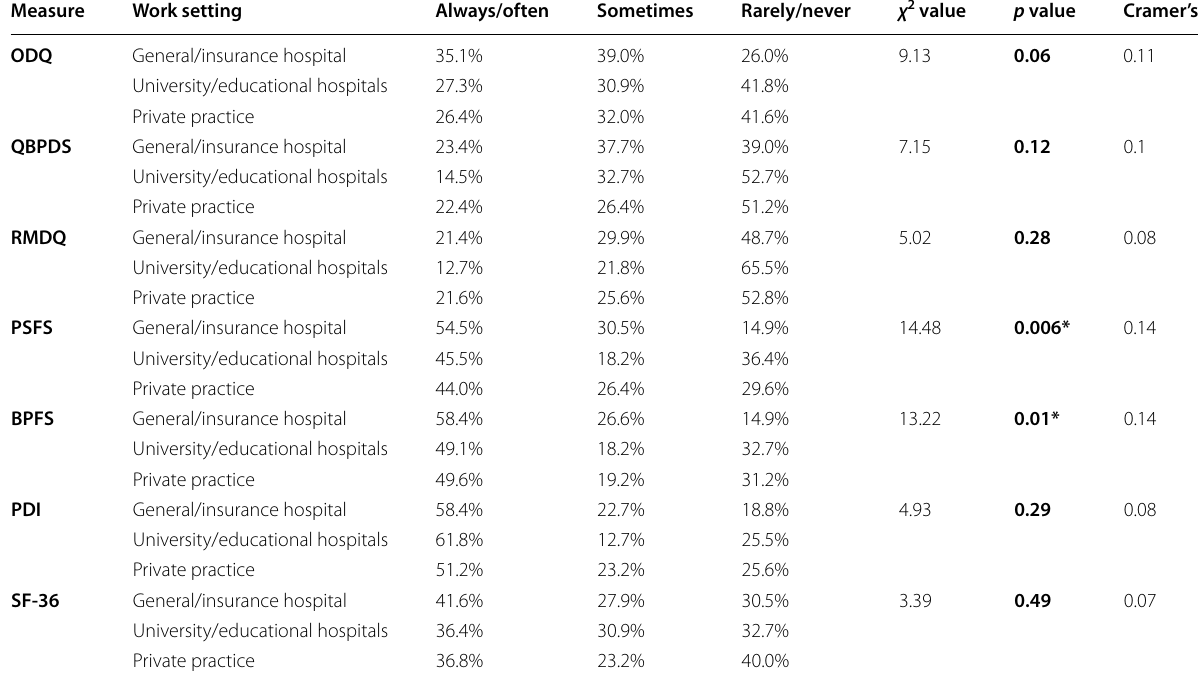
χ 2 , chi-squared value; p value, probability value; *significant